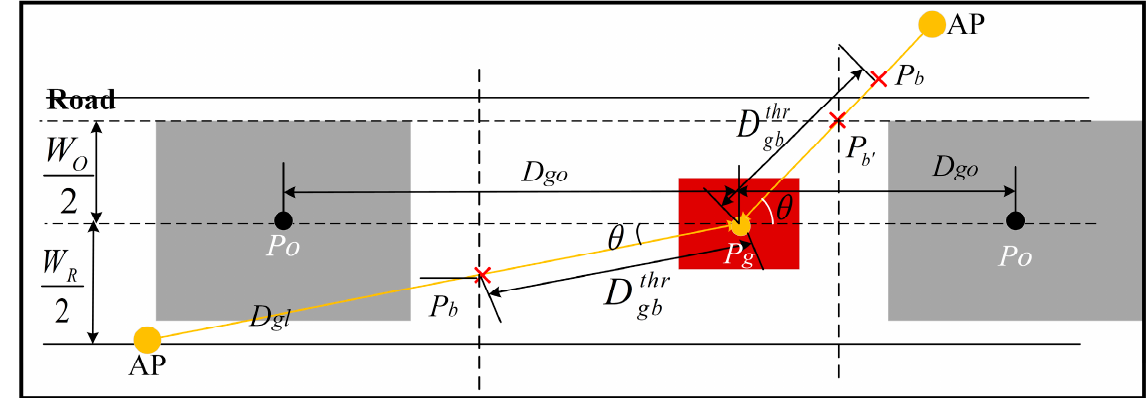
Figure 3. Analysis of link blockage caused by dynamic obstacle.